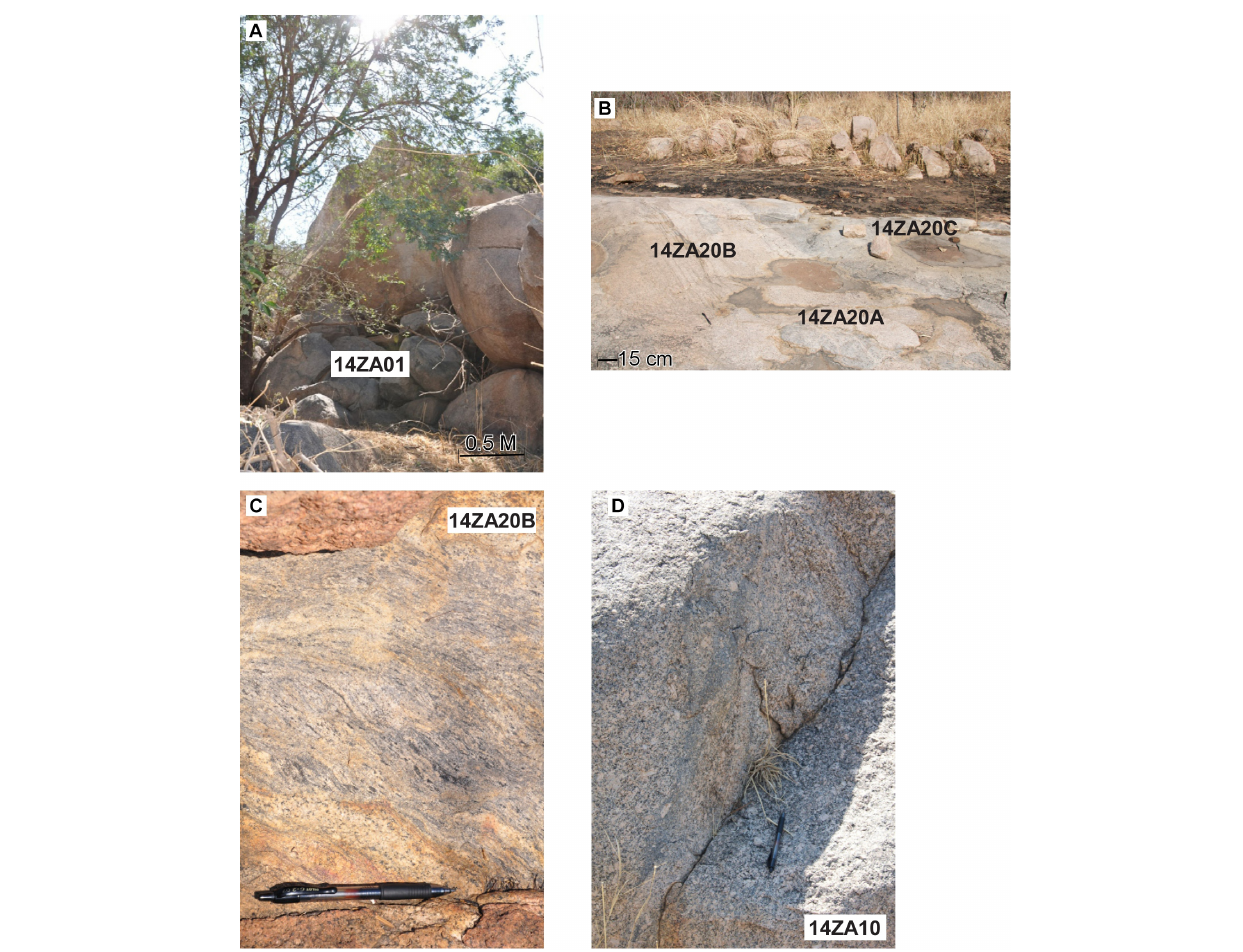
FIGURE 4 | (A) Field photograph of the ∼ 570 Ma post-collisional granites west of Mongo. Field photographs of ∼ 560 Ma post-collisional granites west of El Hidjer (B,C) and near Zan (D)